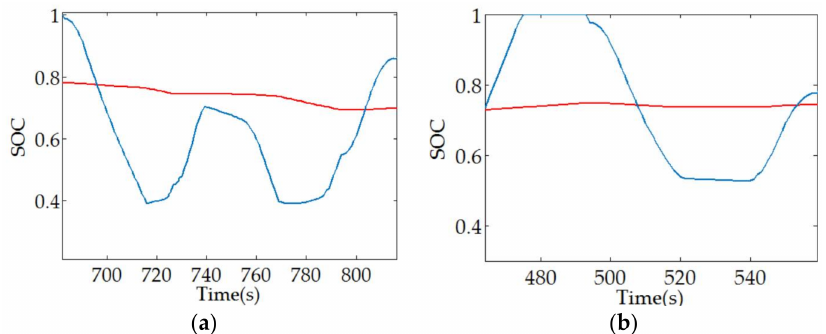
Figure 16. SOC curves of the battery and the supercapacitor. ( a ) Long station spacing. ( b ) Short station